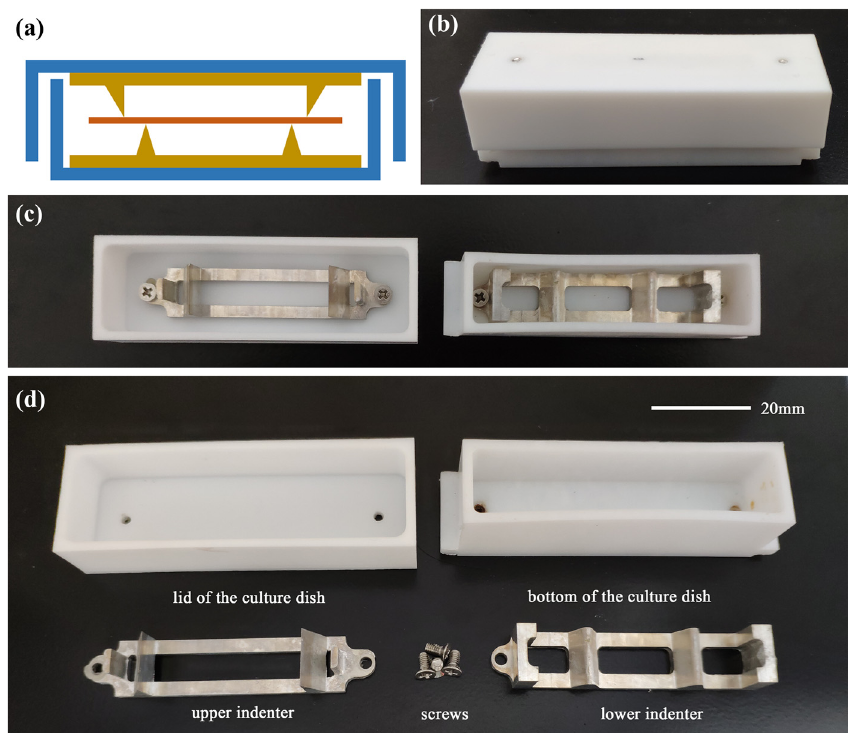
Figure 3: Schematic diagram of the four - point bending device: ( a ) schematic diagram of the loading process of the bone slice; ( b and c ) photograph of the complete four - point bending device; ( d ) photograph of the demounted four - point bending